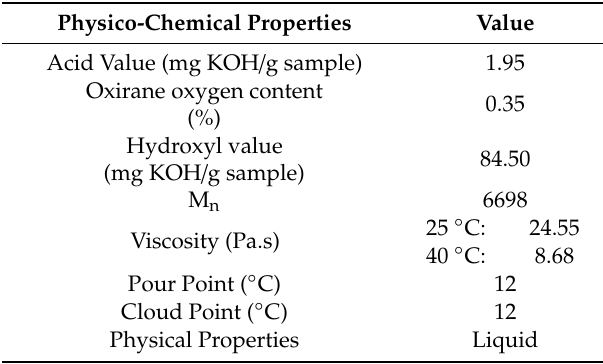
Table 1. Physico-chemical properties of palm oil-based polyester